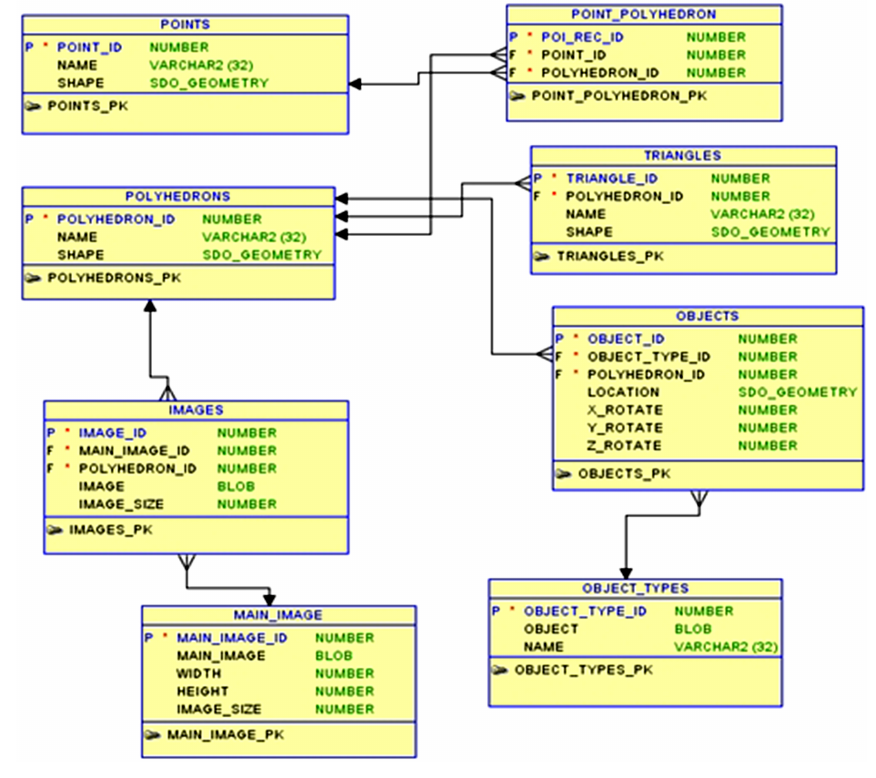
Figure 2. ER diagram of the data stored in tables.